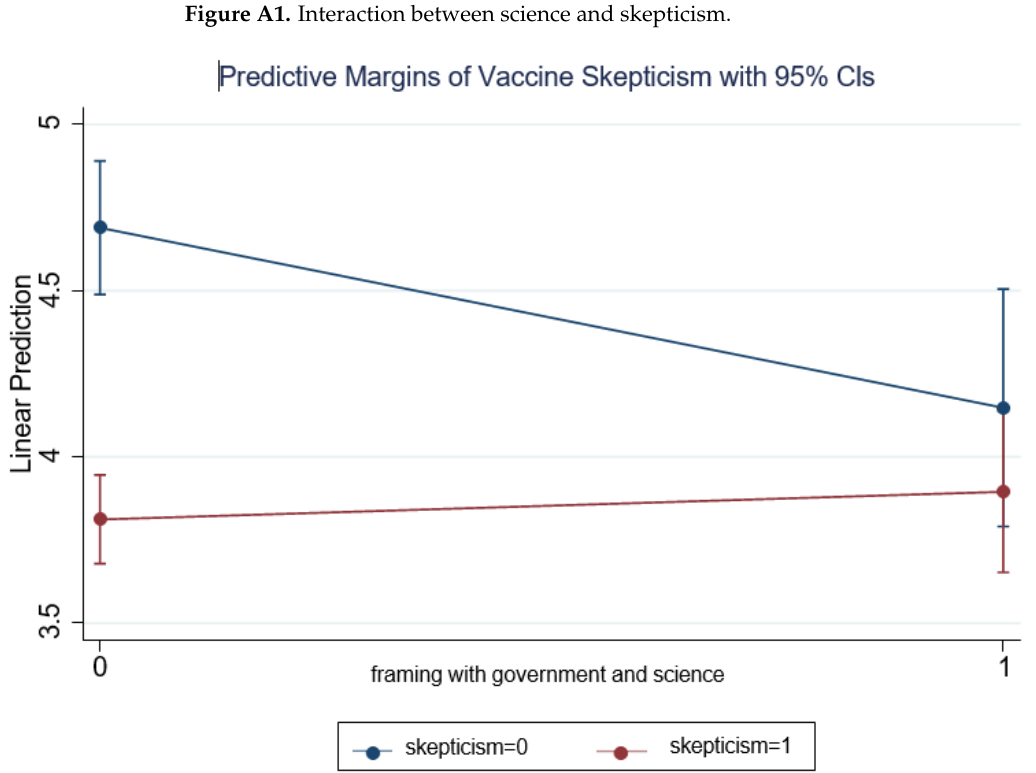
Figure A2. Interaction between both science and government (frame and channel) and skepticism. Table A3. Vaccine information frame, channel, and vaccination willingness.